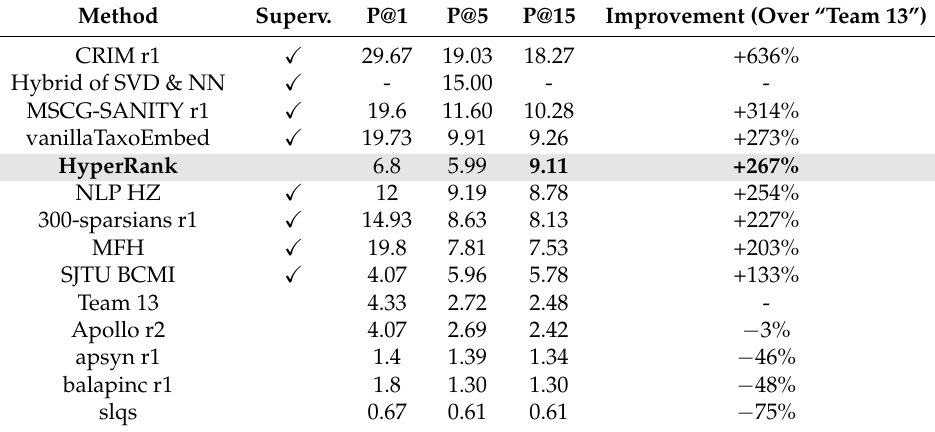
Table 4. Results of evaluation on 1A